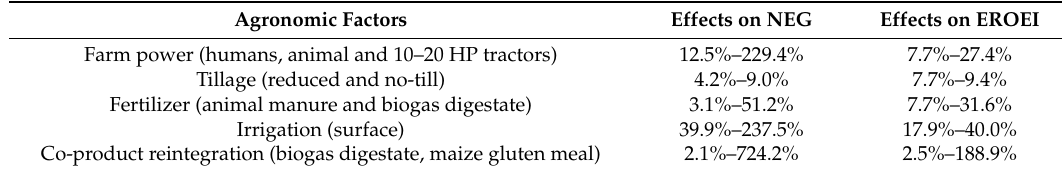
Table 4. Individual positive effects of different agronomic factor